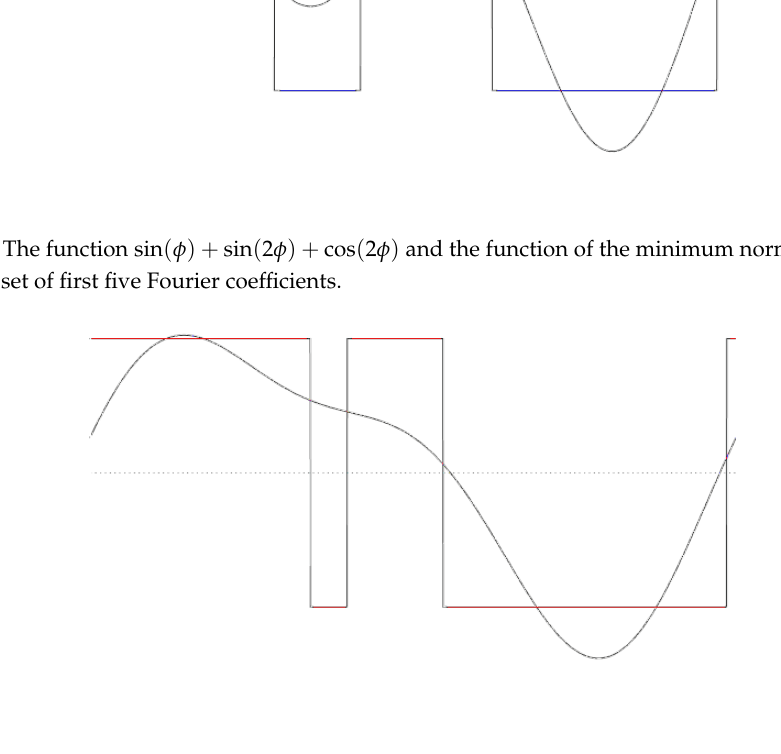
Figure 2. The function 4sin ( φ ) + sin ( 2 φ ) + cos ( 2 φ ) and the function of the minimum norm (cid:107) · (cid:107) ∞ with the same set of first five Fourier